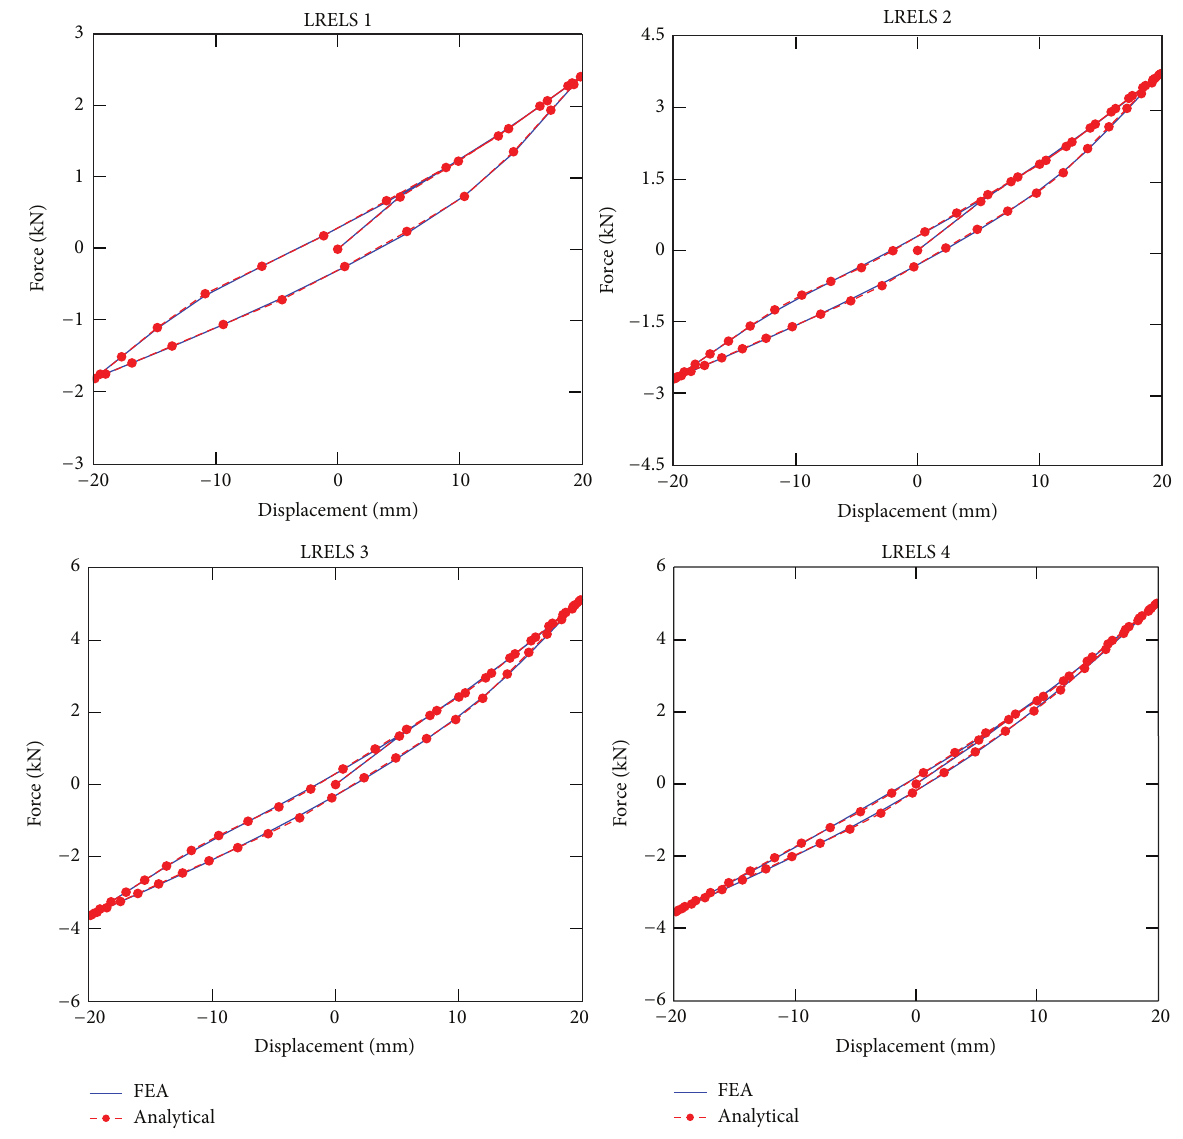
Figure 9: Vertical force-displacement